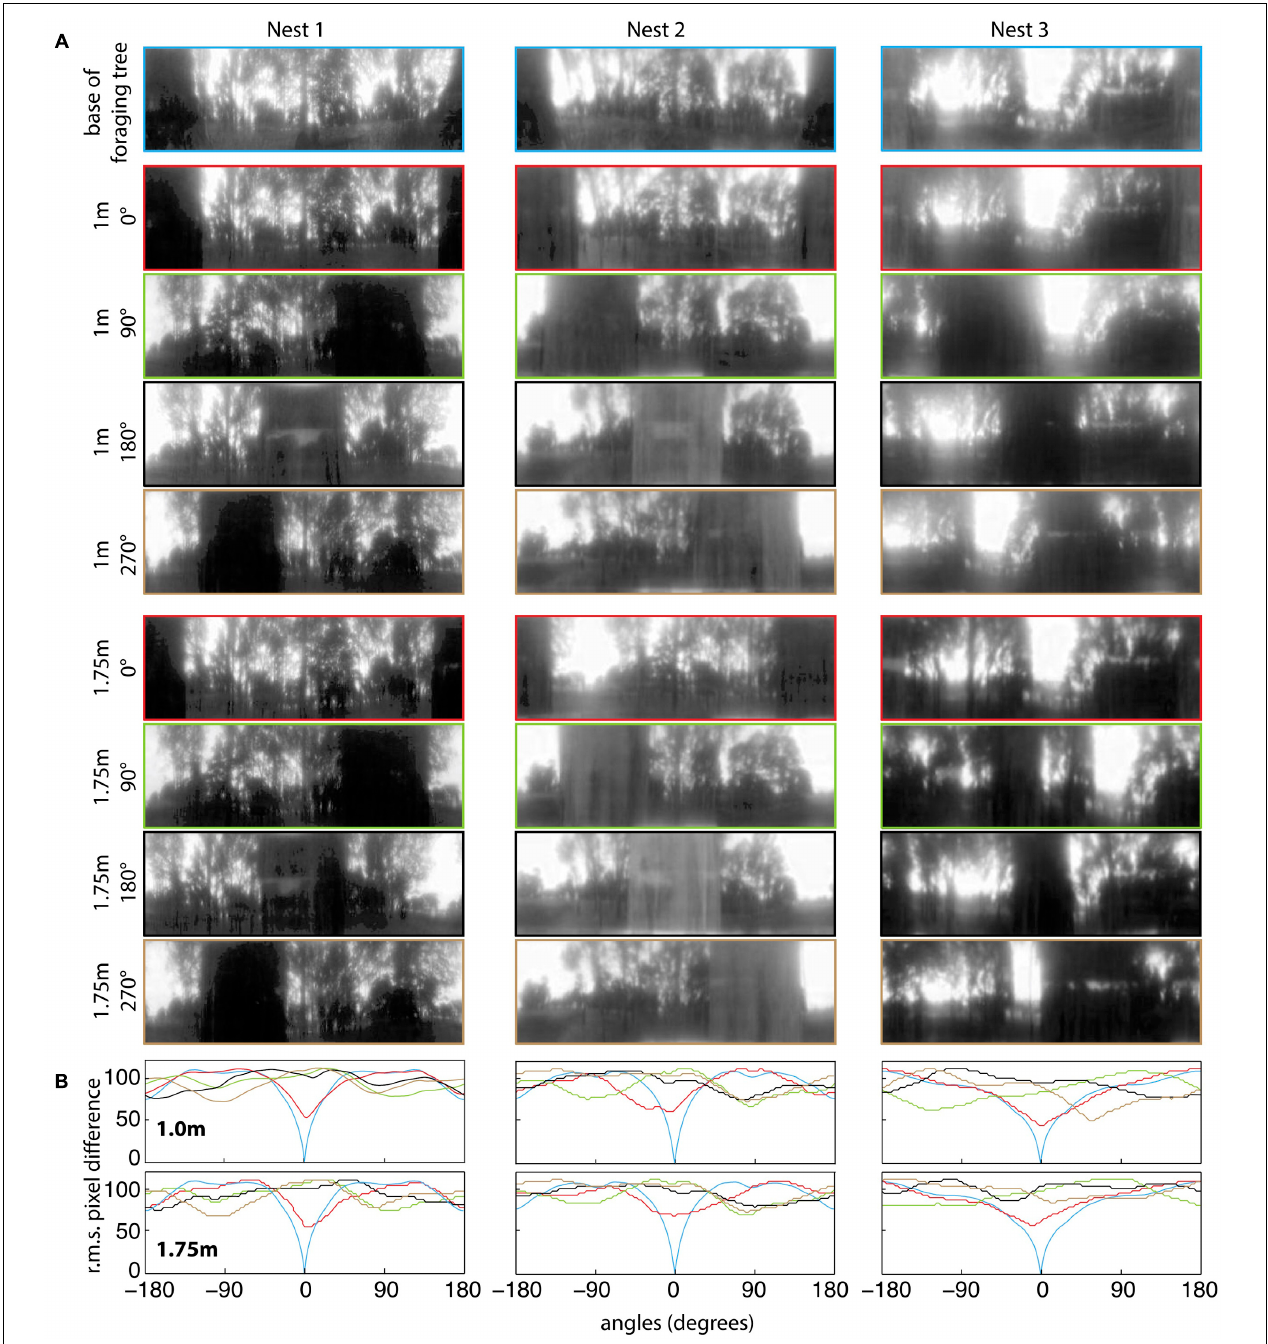
FIGURE 7 | Quantifying panorama changes at the four displacement directions and at two elevations on the foraging tree at the three nests. (A) Panoramic images at the base of the foraging tree (blue), 1 m in height at 0 ◦ (red), 90 ◦ (green), 180 ◦ (black), 270 ◦ (orange) and 1.75 m in height at 0 ◦ (red), 90 ◦ (green), 180 ◦ (black), 270 ◦ (orange). Nest orientation is at the centre of each image and images were downscaled to 1 pixel per 1 ◦ to resemble the ant’s visual acuity, filtered through only the blue colour channel and oriented with the nest centred. (B) The rotIDF compares the root mean square pixel difference between the panorama at the base of the foraging tree with itself, and the foraging tree at both 1 and 1.75 m at each direction. The nest direction in all comparisons is centred at 0 ◦ .